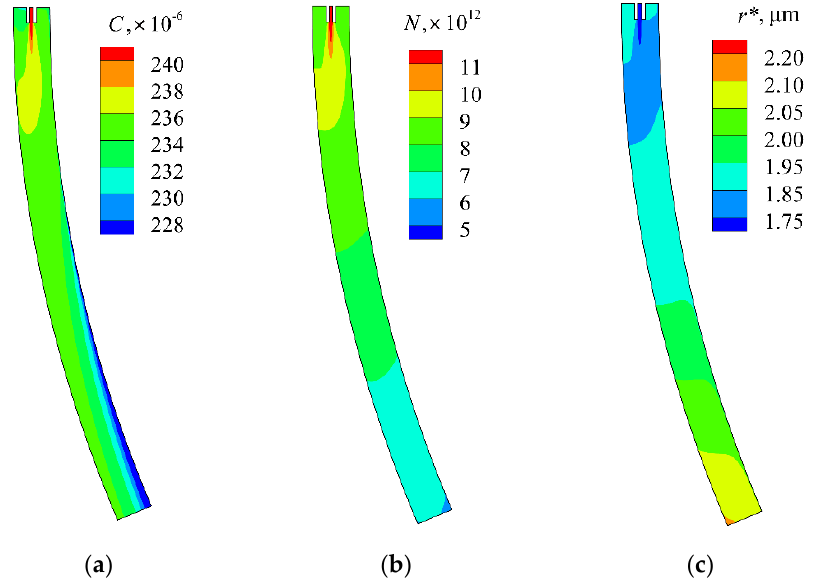
Figure 9. Inclusion distribution at vertical longitudinal-section in curved bloom continuous caster without M-EMS: ( a ) volume concentration; ( b ) number density; ( c ) characteristic radius.